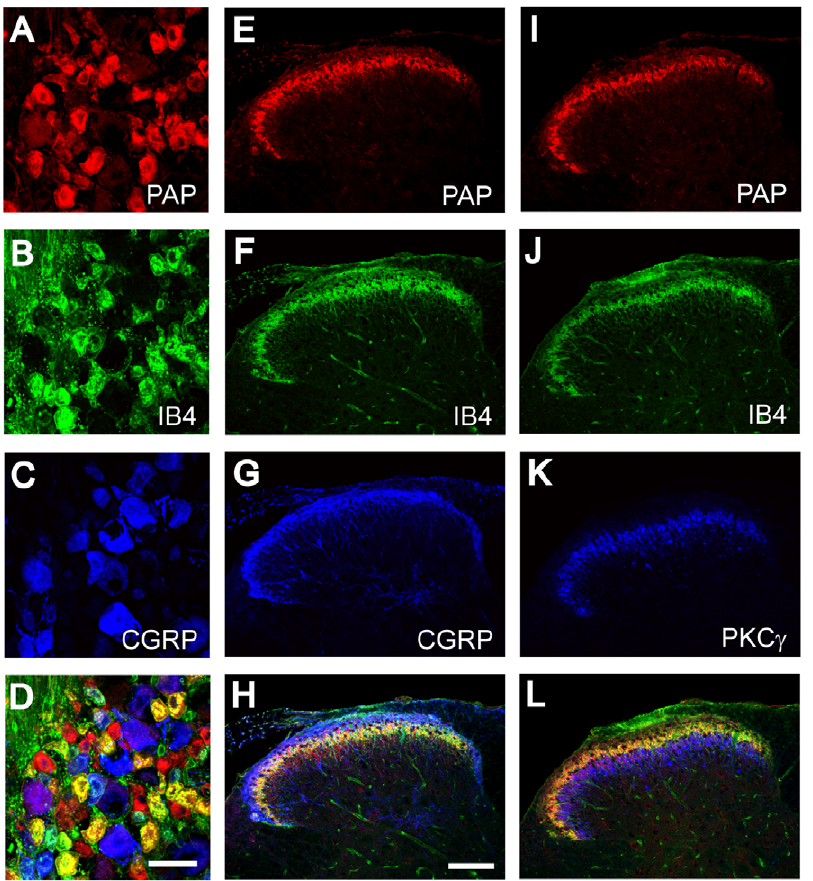
Figure 2. Chicken antibody detects PAP in mouse DRG neurons and dorsal spinal cord. (A–D) Sections from mouse L4-L6 DRG and (E–L) lumbar spinal cord were stained with chicken anti-PAP antibodies (red) and with antibodies against various sensory neuron markers and spinal interneuron marker PKC c (blue, green). (D, H, L) Merged images. All images were acquired by confocal microscopy. Scale bar in (D) 50 m m, (H) 100 m m. (Figure 3A, E, I). In lumbar DRG, 92.5% of the PAP + cells bound the nonpeptidergic marker IB4 + whereas 31.8% of PAP + cells contained the peptidergic marker CGRP + (n= 443 cells counted